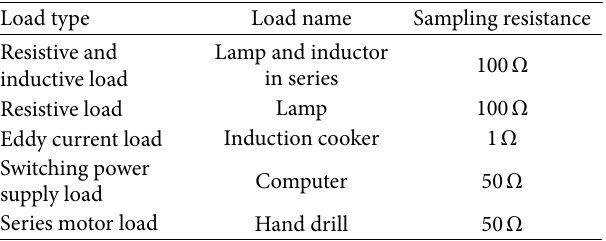
Figure 1: The block diagram of complete description. Table 1: Load type and sampling resistance.